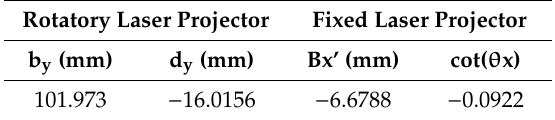
Table 2. Geometric parameters of the laser projectors in the vision sensor after calibration.